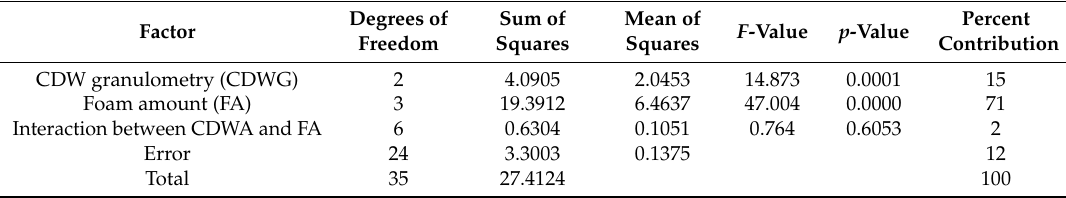
Table 3. Compressive strength (CS) An analysis of variance (ANOVA). Factor Degrees of Sum of Mean of Freedom Squares F -Value p -Value Squares